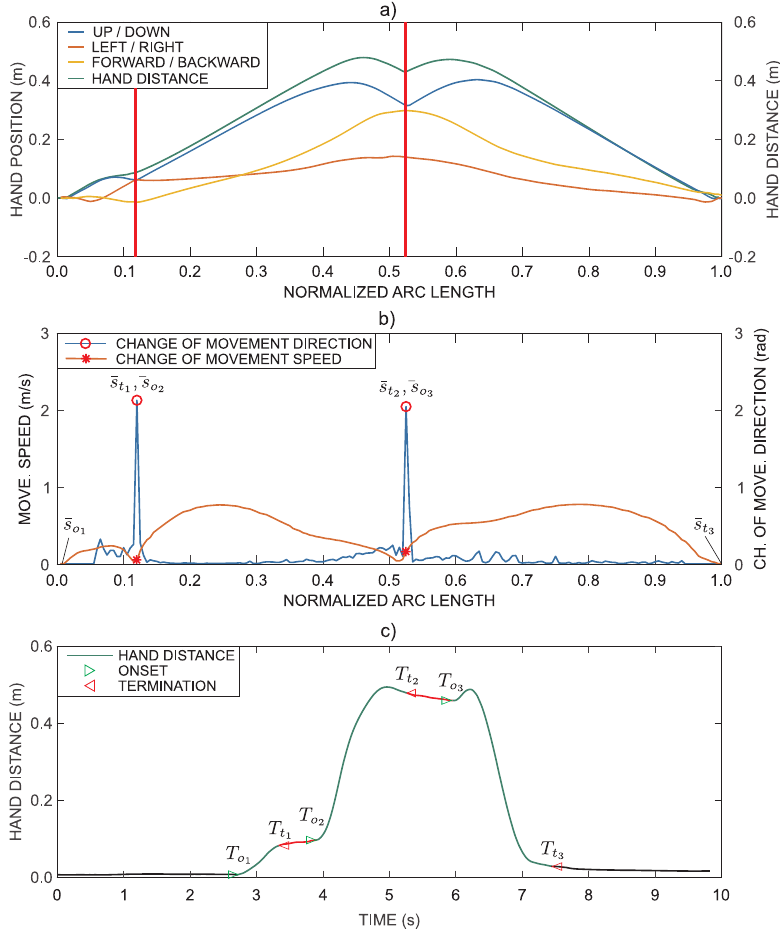
Figure 3. Movement segmentation for the task that requires grasping a block and transferring it onto a shelf. ( a ) Hand trajectory parameterized by the normalized arc length; ( b ) changes in movement direction and movement speed parameterized by the normalized arc length; and ( c ) transformation of segmented path into time domain. T t present the termination time and T o the onset time for phase i i i